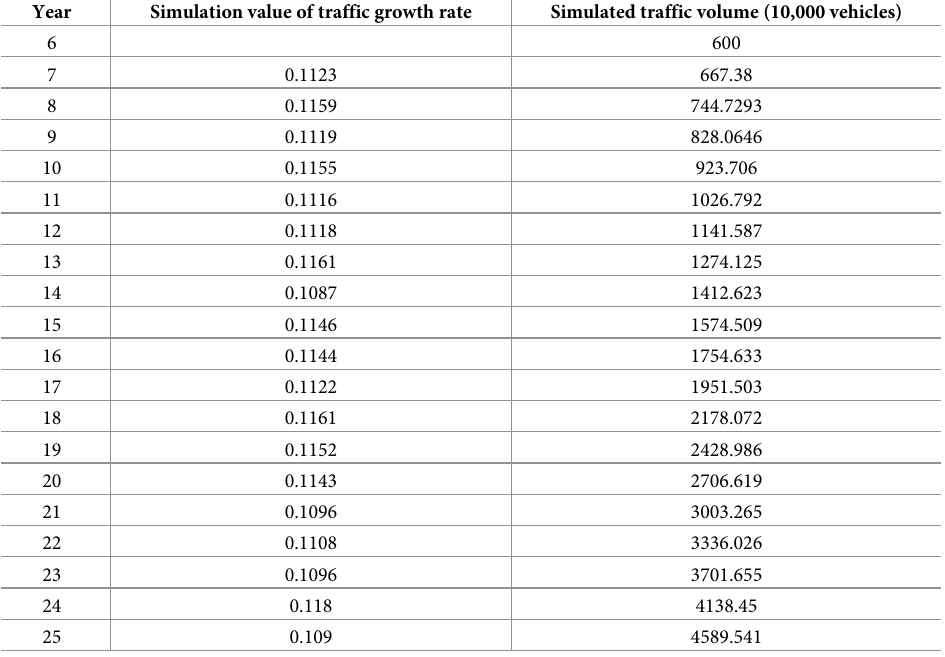
Table 3. Summary of simulation